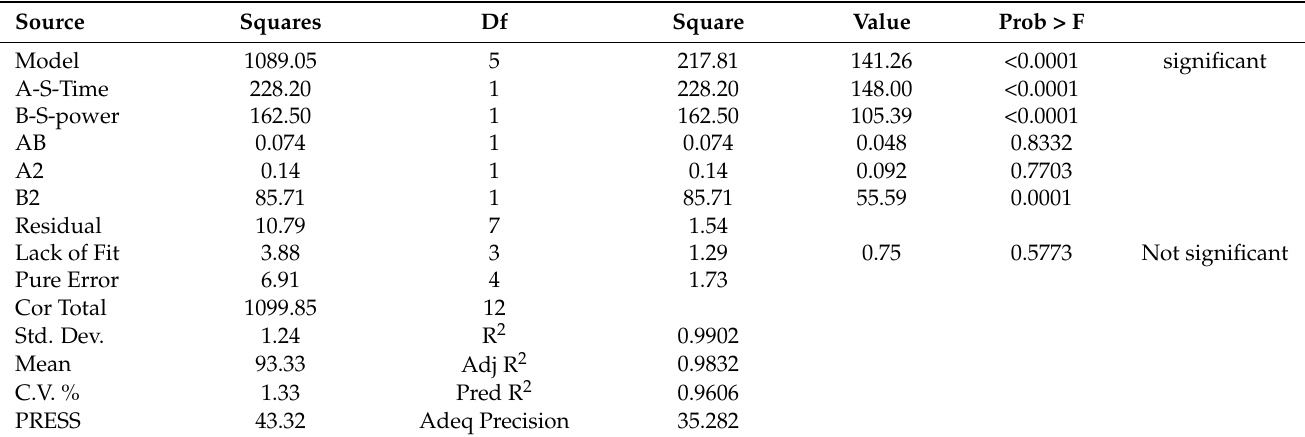
Table 2. Regression coefficients of the fitted second-order polynomials representing the relationship between the responses and